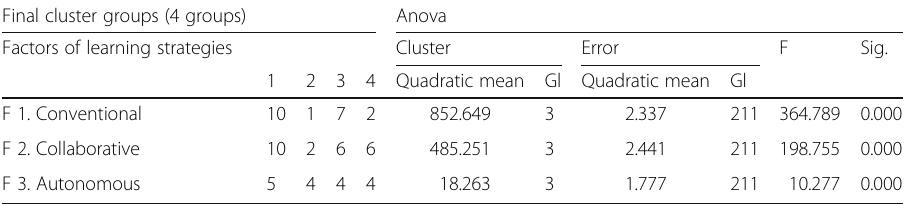
Table 3 Results of the partition in four clusters and exploratory ANOVA Final cluster groups (4 groups) Factors of learning strategies